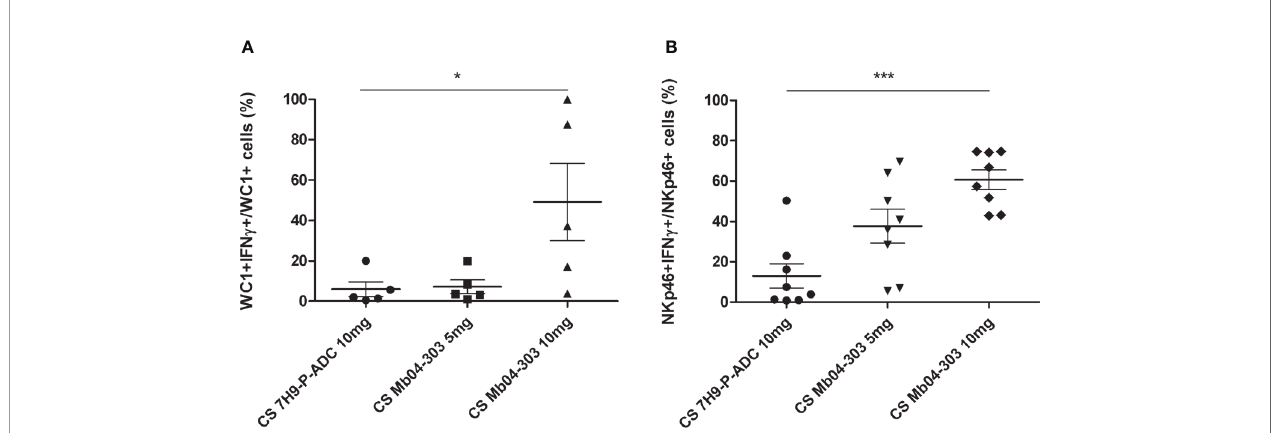
FIGURE 6 | IFN- g intracytoplasmic quanti fi cation by fl ow cytometry in co-cultures of cells stimulated with 5 or 10 mg of Mb04-303 lyophilized culture supernatants (CS). Lyophilized culture medium alone (CS 7H9-P-ADC 10mg) was used as a negative control. For each animal sample and condition tested, a single cell well was analyzed. Each symbol represents an individual animal; horizontal lines represent mean values and whiskers SEM. The results are expressed as IFN- g + cells in total WC1+ (A) (N=5) and NKp46+ (B) (N=8) populations (*p < 0.05 and ***p < 0.0001 signi fi cant differences by Friedman test with Dunn ’ s post-test for multiple comparisons).